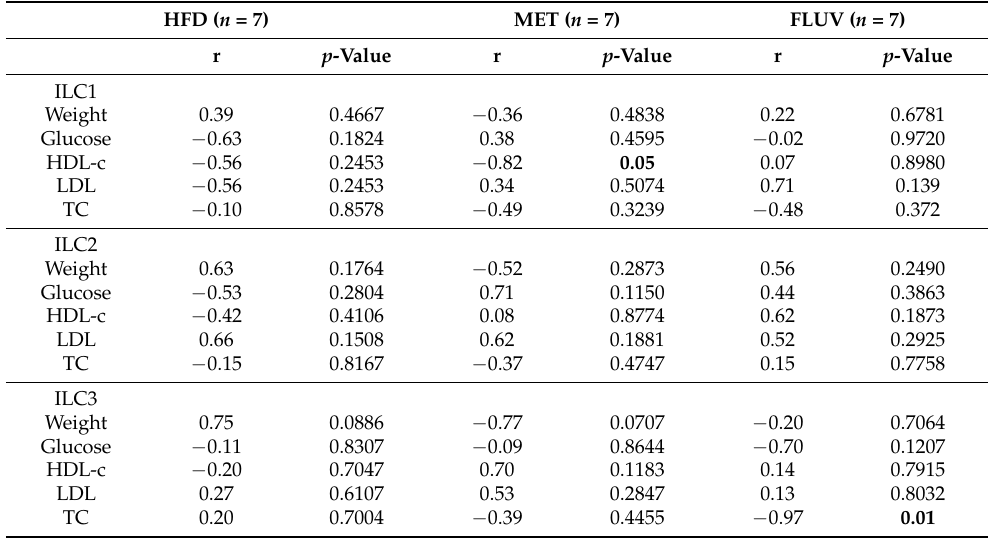
Table 3. Associations between caspase-3 expression on innate lymphoid cells and metabolic parameters. HFD ( n =